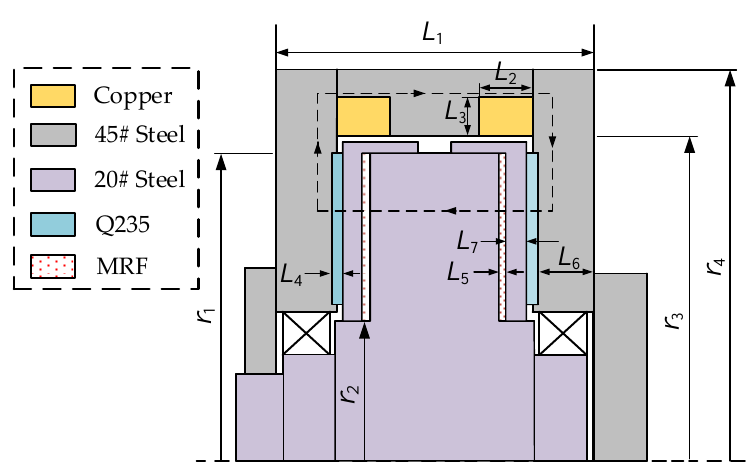
Figure 2. Magnetic circuit model of variable thickness MRF transmission device.